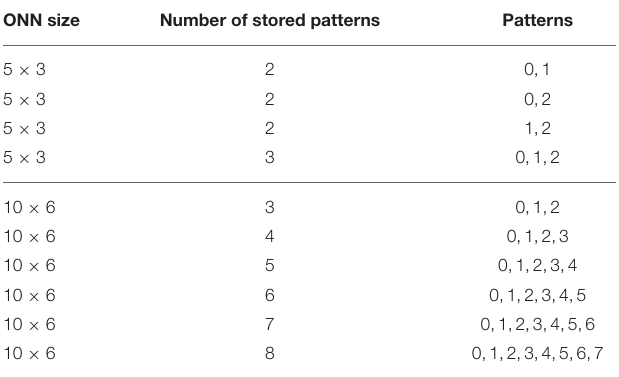
TABLE 1 | Pattern combinations used for implementation